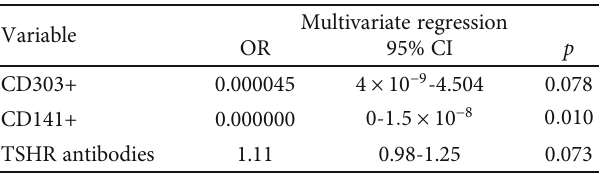
Table 4: Multivariate logistic regression analysis of the multivariate GO determinants (variables), performed in all patients, i.e., with and without (controls, GD) GO. OR: odds ratio; CI: con fi dence interval. Values p < 0 : 05 are considered statistically signi fi